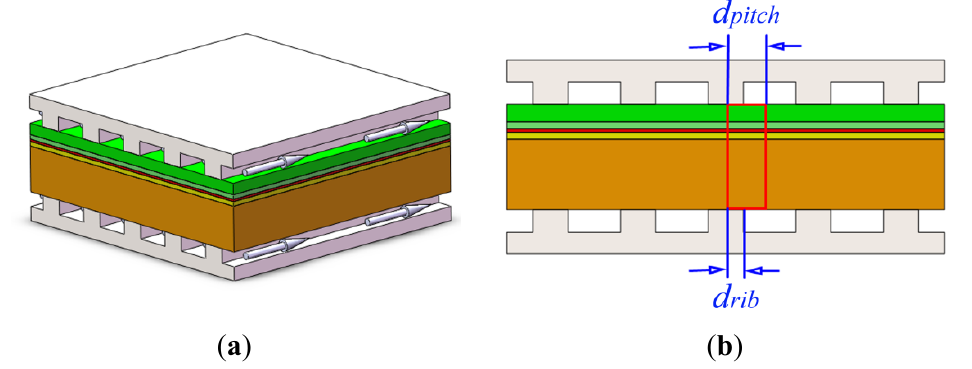
Figure 1. Schematic of ( a ) a cathode-supported SOFC stack cell unit and ( b ) cross-section of SOFC stack cell